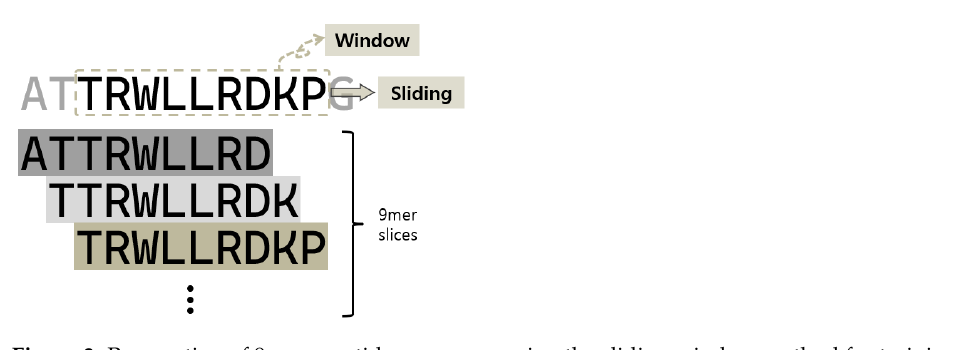
Table 1. Five different model architectures used in